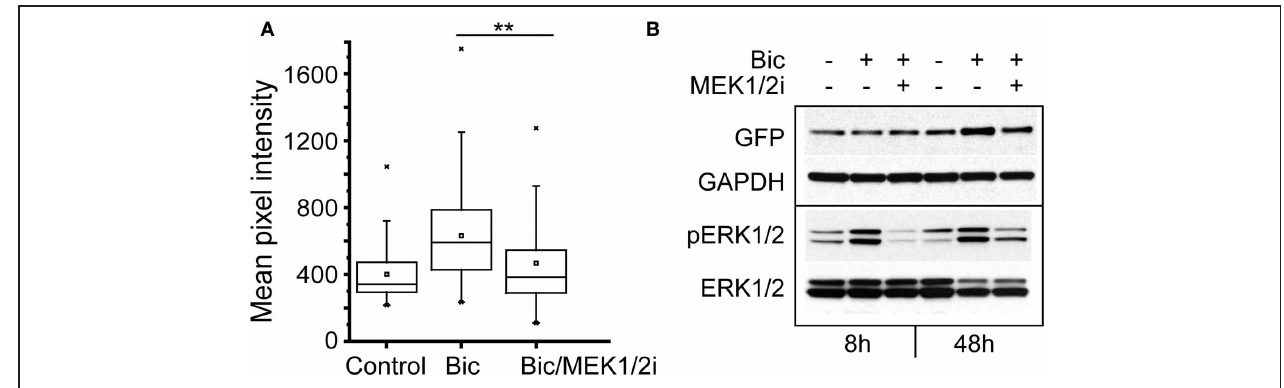
Between group statistical significance was determined using the paired sample Wilcoxon signed rank test, ∗∗ p < 0 . 006. (B) Representative western blot of neuronal cultures treated with bicuculline for 8 and 48h in the presence or absence of the MEK1/2 inhibitor SL327. Glyceraldehyde-3-phosphate dehydrogenase (GAPDH) was used as a loading